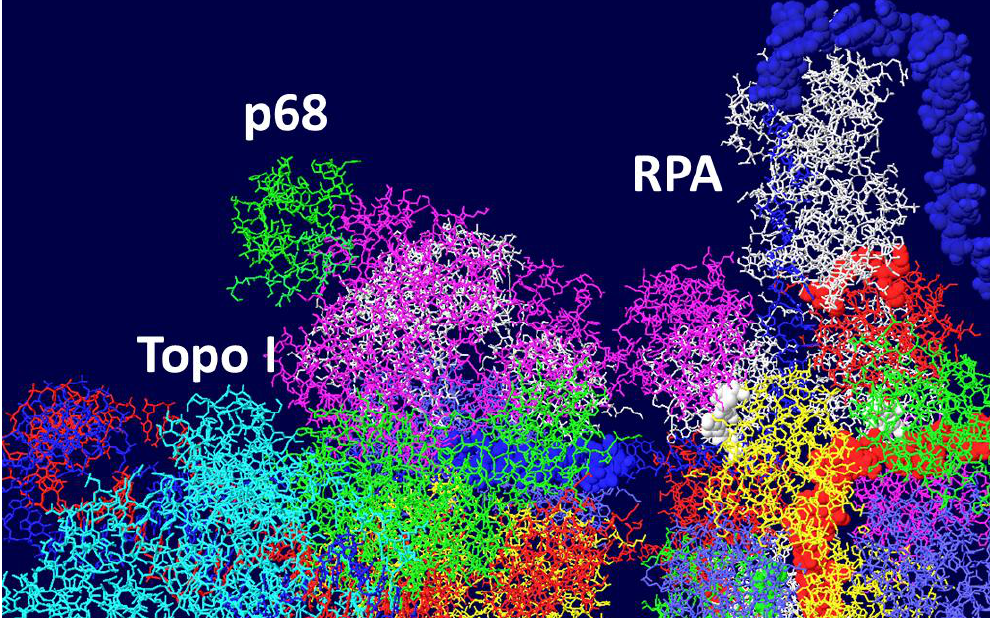
Figure 8. Model of the Topo I/RPA/T DH with part of pol/prim. A portion of the pol/prim p68 subunit was fitted onto the Topo I/RPA/T DH structure shown in Figure 7. Topo I is in cyan, p68 in green and RPA in white. The rest of the pol/prim molecule may be able to interact with topo I and